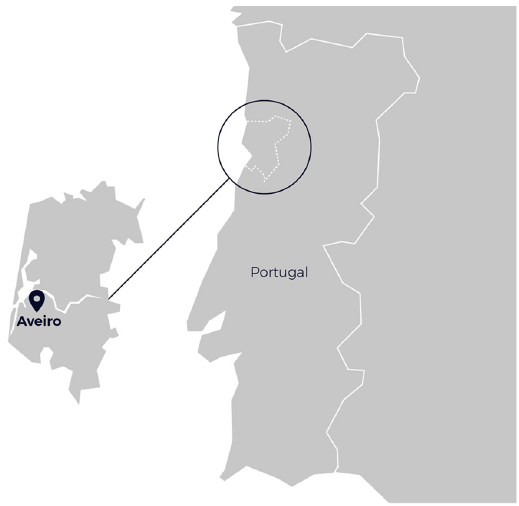
Figure 1. Location of the district of Aveiro.